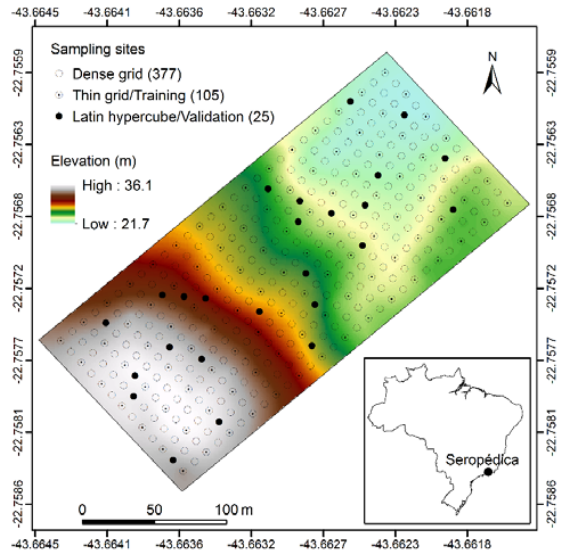
Figure 1. Location of the 3.4-ha study area in Seropédica, southeastern Brazil, digital terrain model, and sampling design.